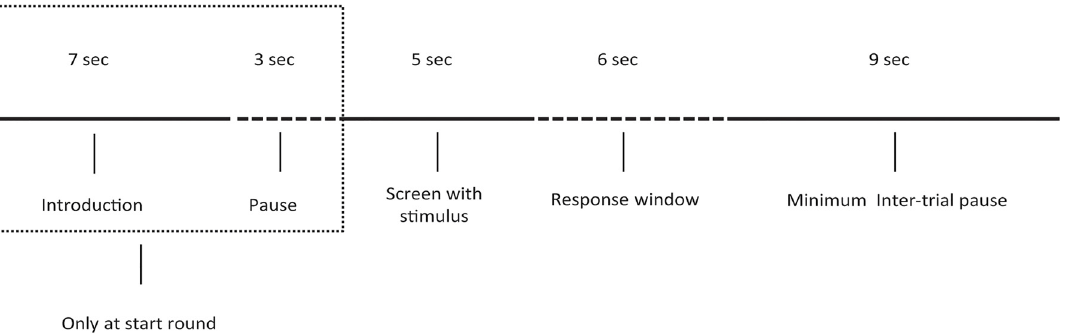
Fig 1. Trial structure. Every trial lasted for 20 seconds. During the first 5 seconds (Screen with stimulus) three objects were shown: a face, a Yes/No question about a face-characteristic and a double task. Then a response window was shown for 6 seconds. In these seconds participants first answered the question and then solved the double task, both orally. Finally, a white screen appeared for 9 seconds before a new trial